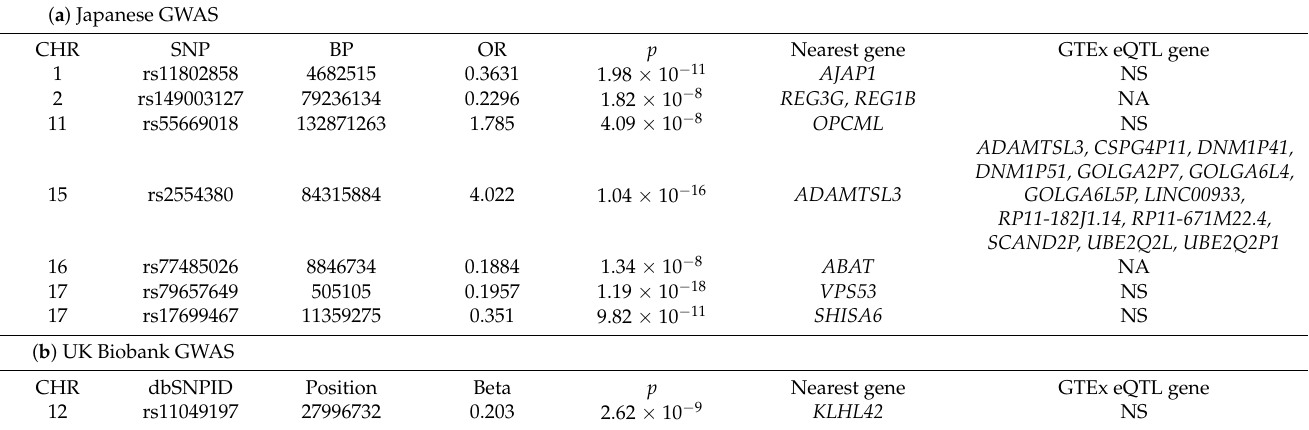
Table 1. Clinical characteristics of Japanese patients with developmental dysplasia of the hip (DDH). Table 2. Significant SNPs from Japanese GWAS and the UK Biobank GWAS. The nearest genes and eQTL genes in GTEx are shown.